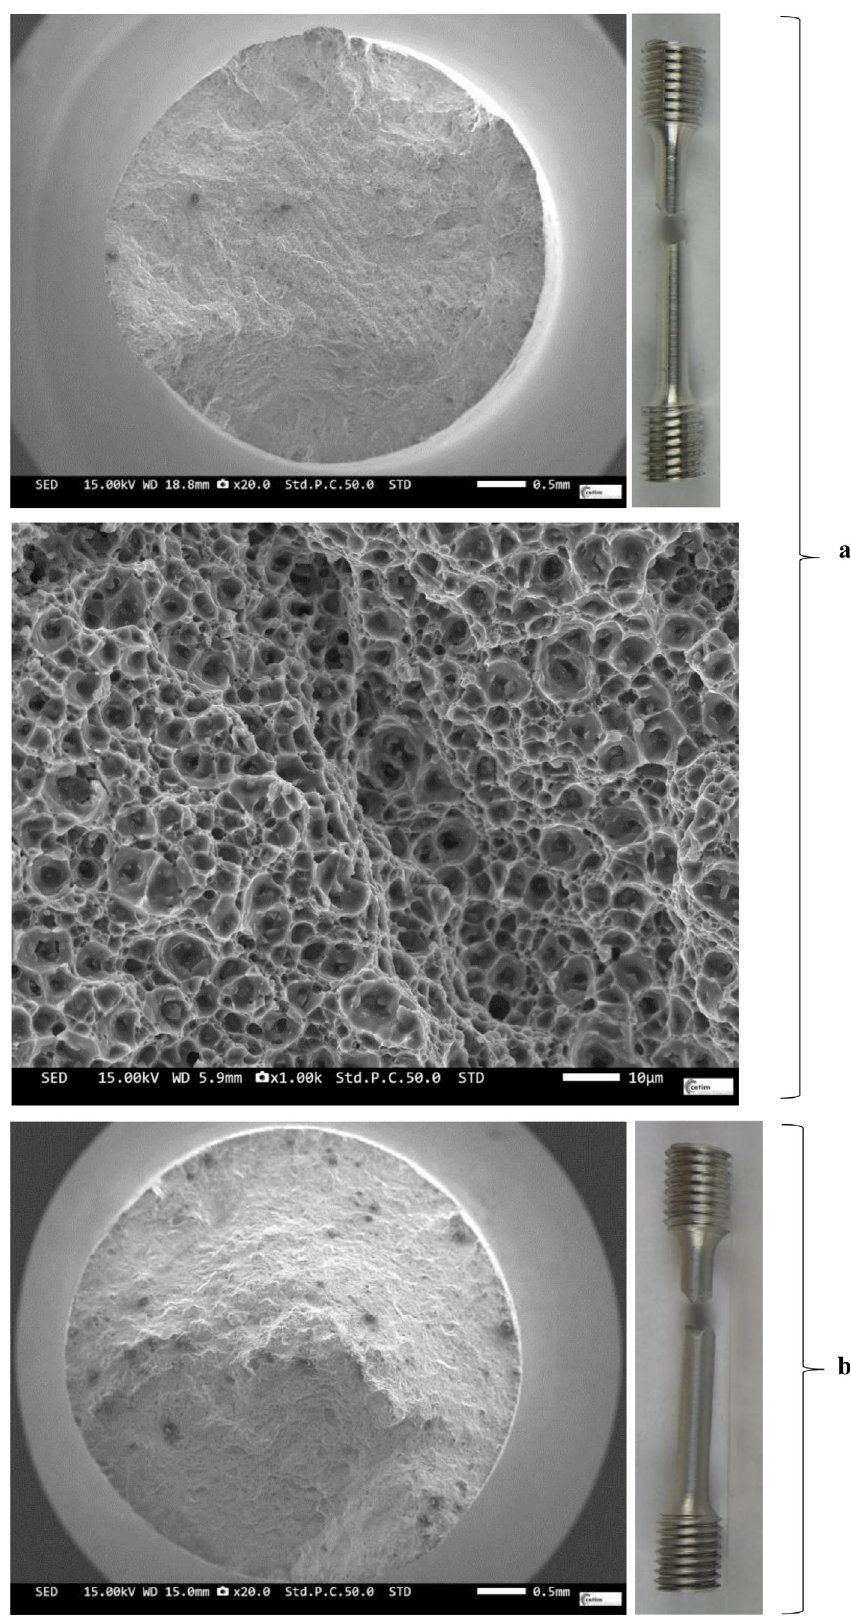
Fig. 10. Fractography (cid:1) Tensile test pieces, T6 temper. (a) Z direction (cid:1) (b) XY